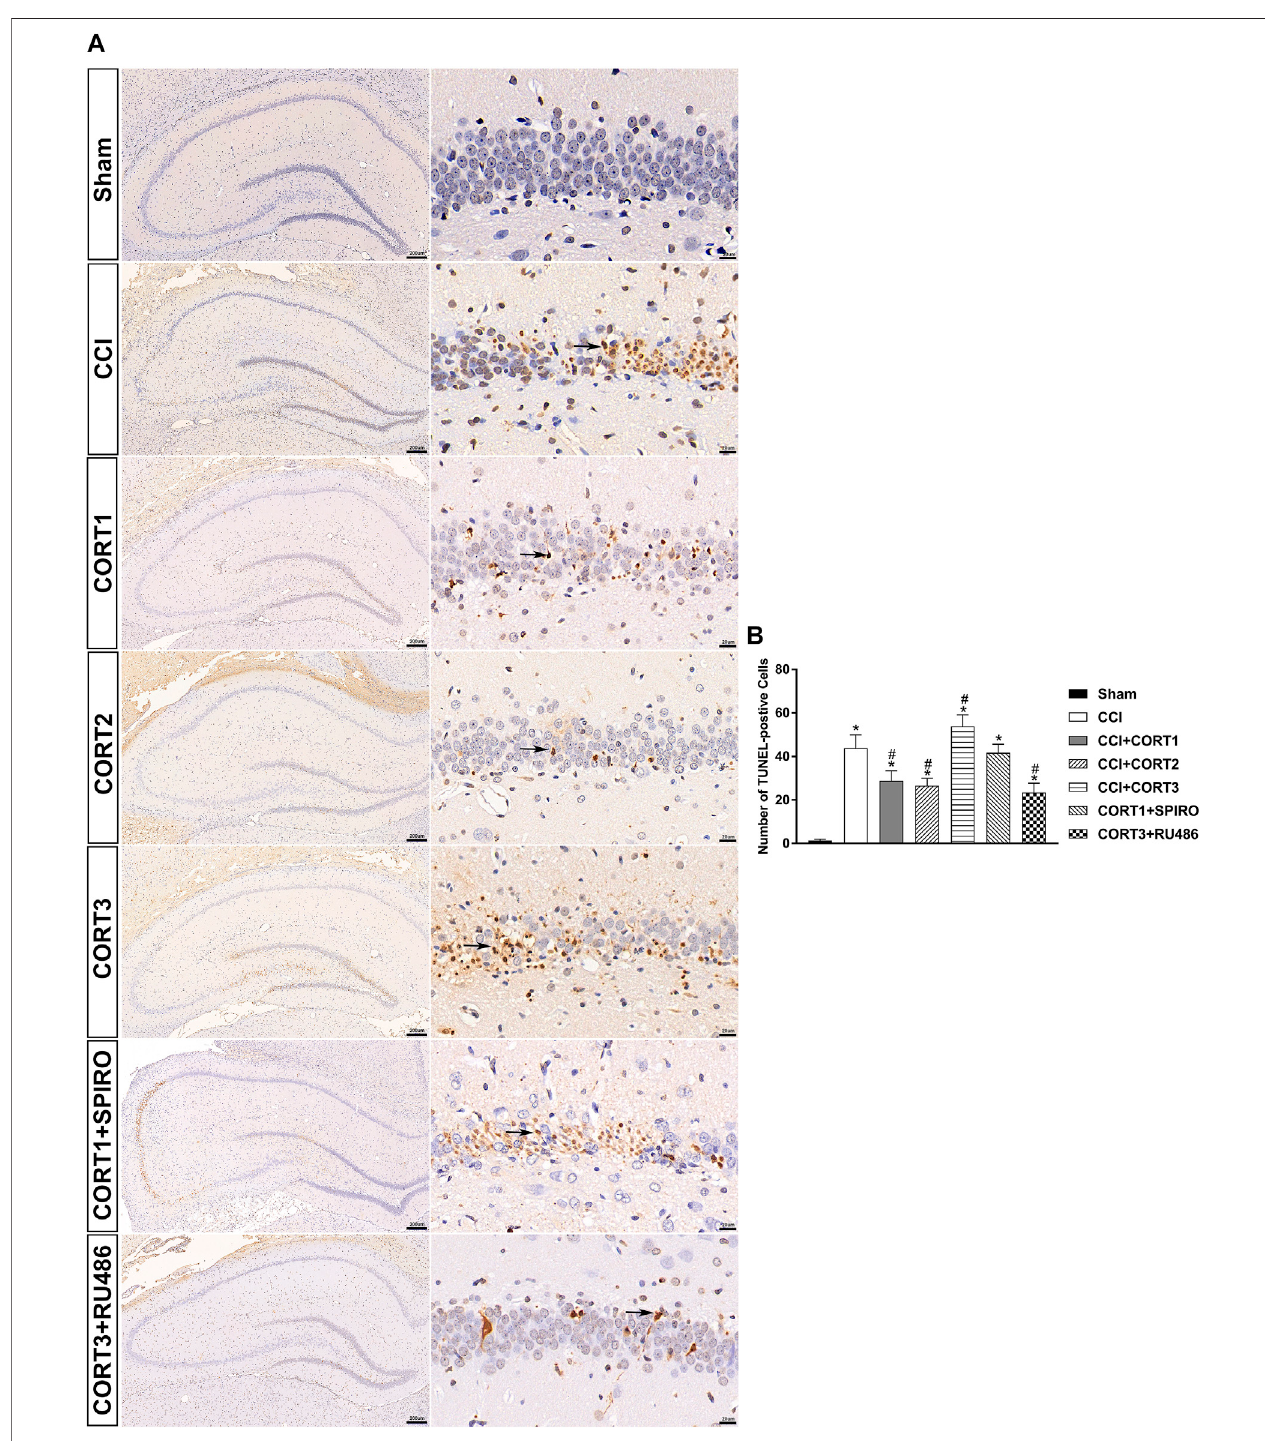
FIGURE 2 | Dose-dependent effects of CORT treatments on the apoptosis of ipsilateral hippocampal neurons after CCI. (A) Representative images of TUNEL- positive cells (black arrow) in the ipsilateral hippocampus 3 days after CCI. (B) Quanti fi cation of apoptotic neurons in the ipsilateral hippocampus. p < 0.05 versus the sham control group; # p < 0.05 versus the CCI control group. The data are presented as the means ± SD. Scale bar (cid:1) 200 μ M for the left column of Panel 2A and 20 μ M for the right column of Panel 2A.